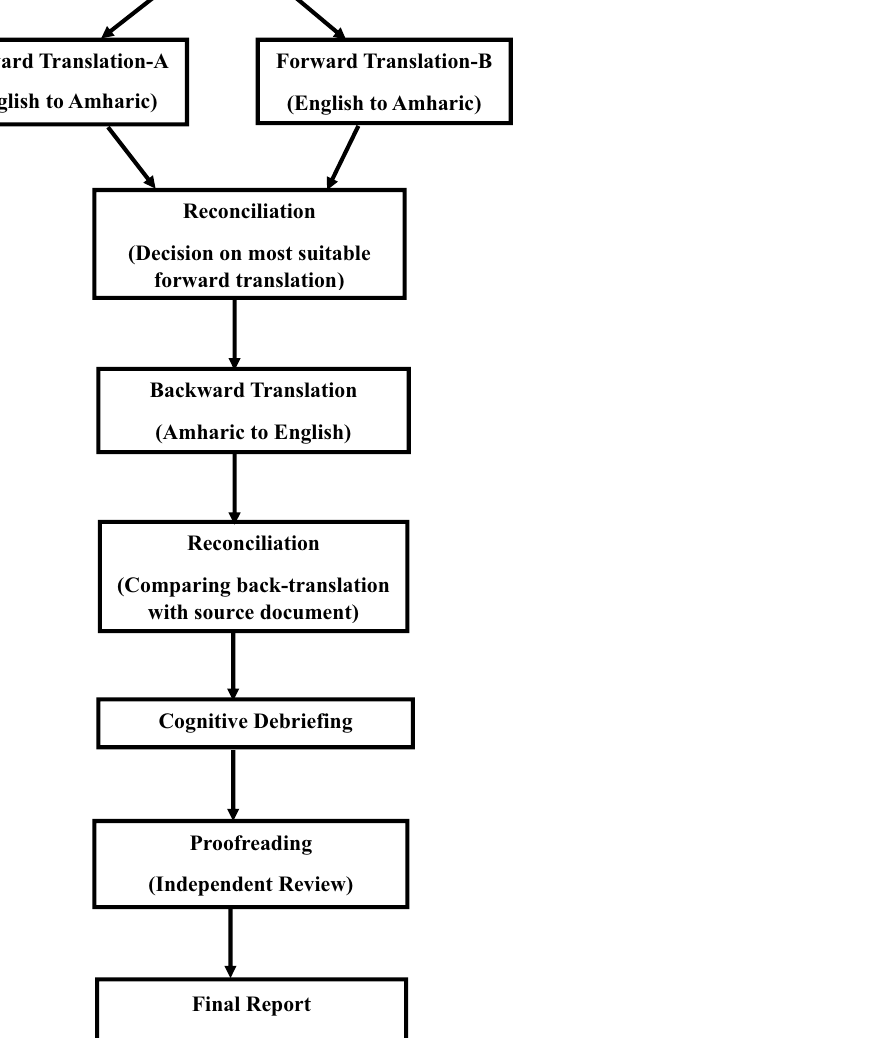
Figure 1. Summary of the steps followed for the translation and cultural adaption of the TBQ into Amharic for Ethiopia context (based on Linguistic Guidance for COA developed by MRT and